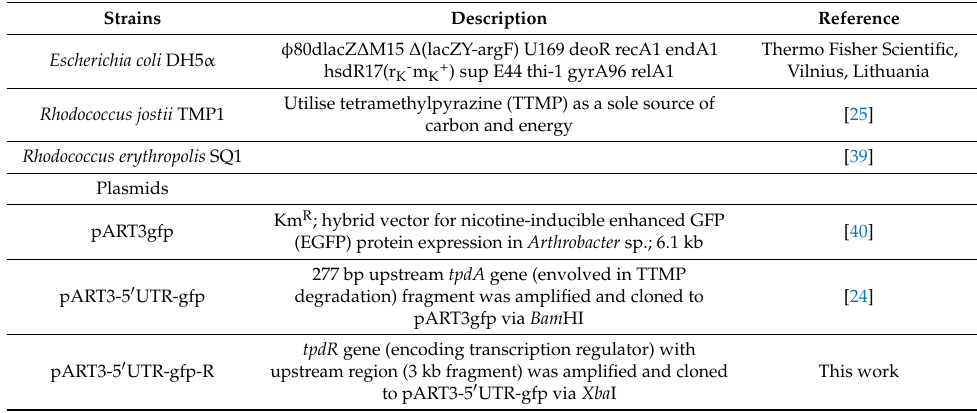
Table 1. Bacterial strains and plasmids used in this study.